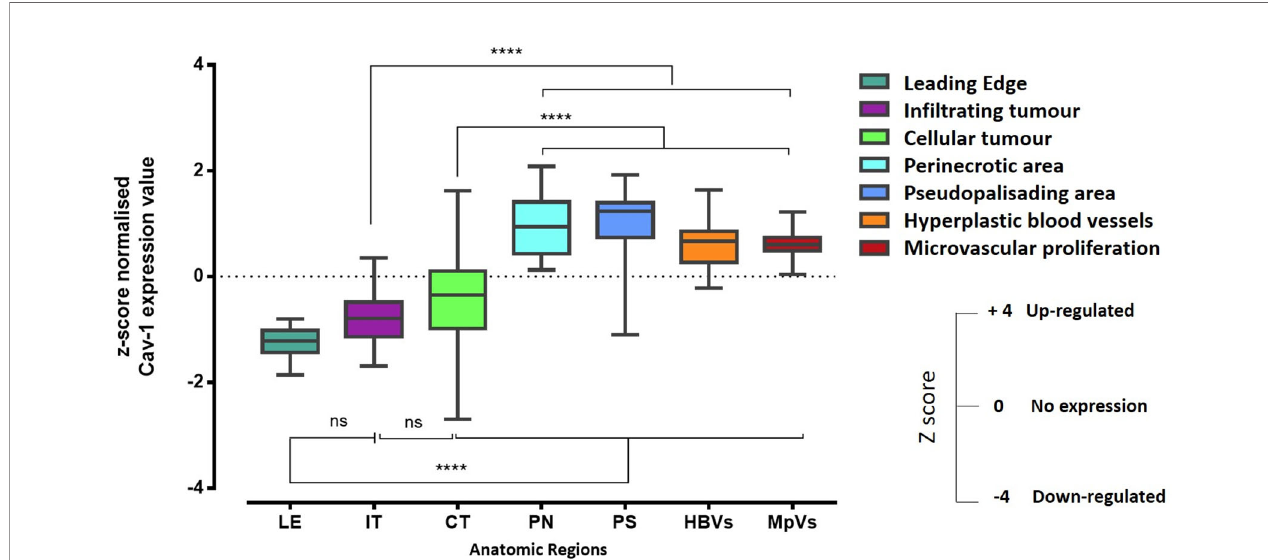
FIGURE 6 | RNA-Seq expression z-score computed for Cav-1 differentially expressed within histological regions of the GB tumour (n-=41). The corresponding histological features are labelled as follows: HBVs, Hyperplastic blood vessels in cellular tumour; MpVs, Microvascular proliferation; PN, Pseudo-palisading cells around necrosis; IT, In fi ltrating tumour; LE, Leading edge; CT, Cellular tumour. Error bars represent the SEM. One-way ANOVA and Tukey ’ s multiple comparison were used; ns, not signi fi cant; ****represents